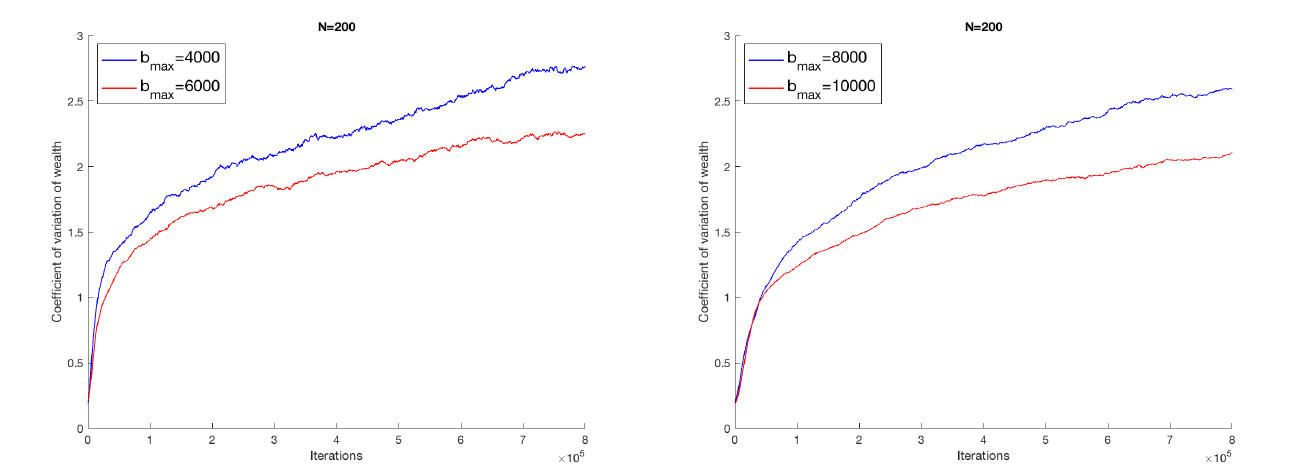
Figure 3. Plot of the coefficient of variation of the amount of money of the economic agents as transactions go on for N = 200 and